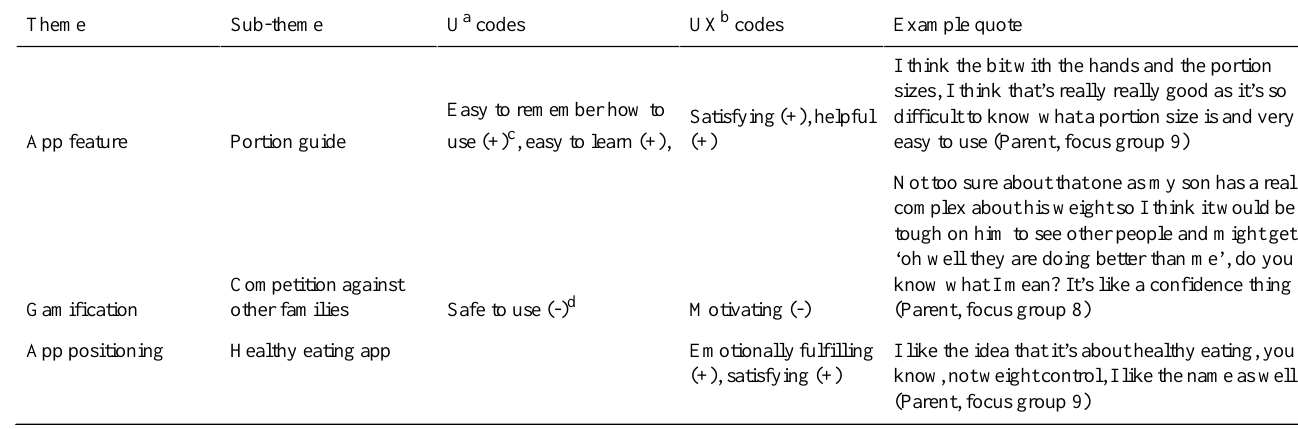
Table 6. Excerpt of results from pilot testing interactive mock-ups with